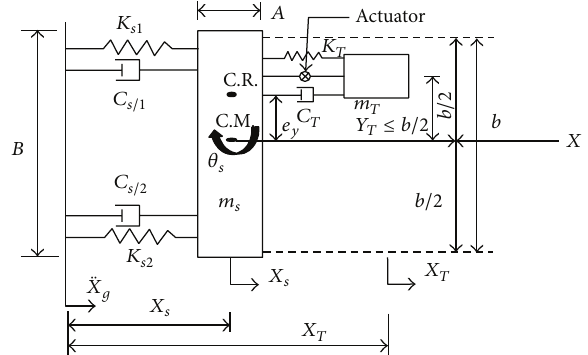
Figure 11: The active tuned mass damper for a 2-DoF structure.